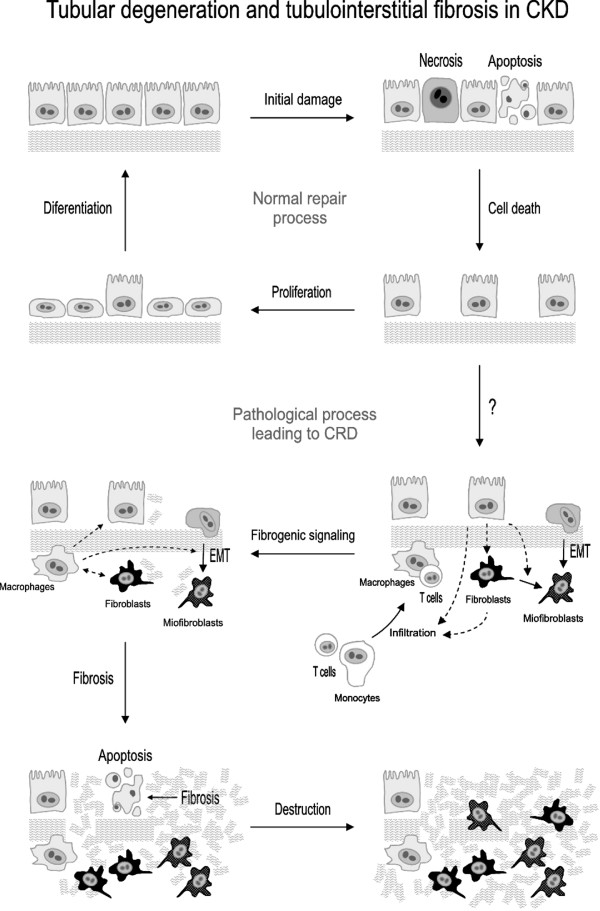
Schematic depiction of the pathological process of tubular degeneration and tubulointerstitial fibrosis characteristic of tubulointerstitial diseases, and also of later stages of glomerular and renovascular diseases leading to chronic kidney disease (adapted from references [87]and [291]). EMT, epithelial to mesenchymal transition.